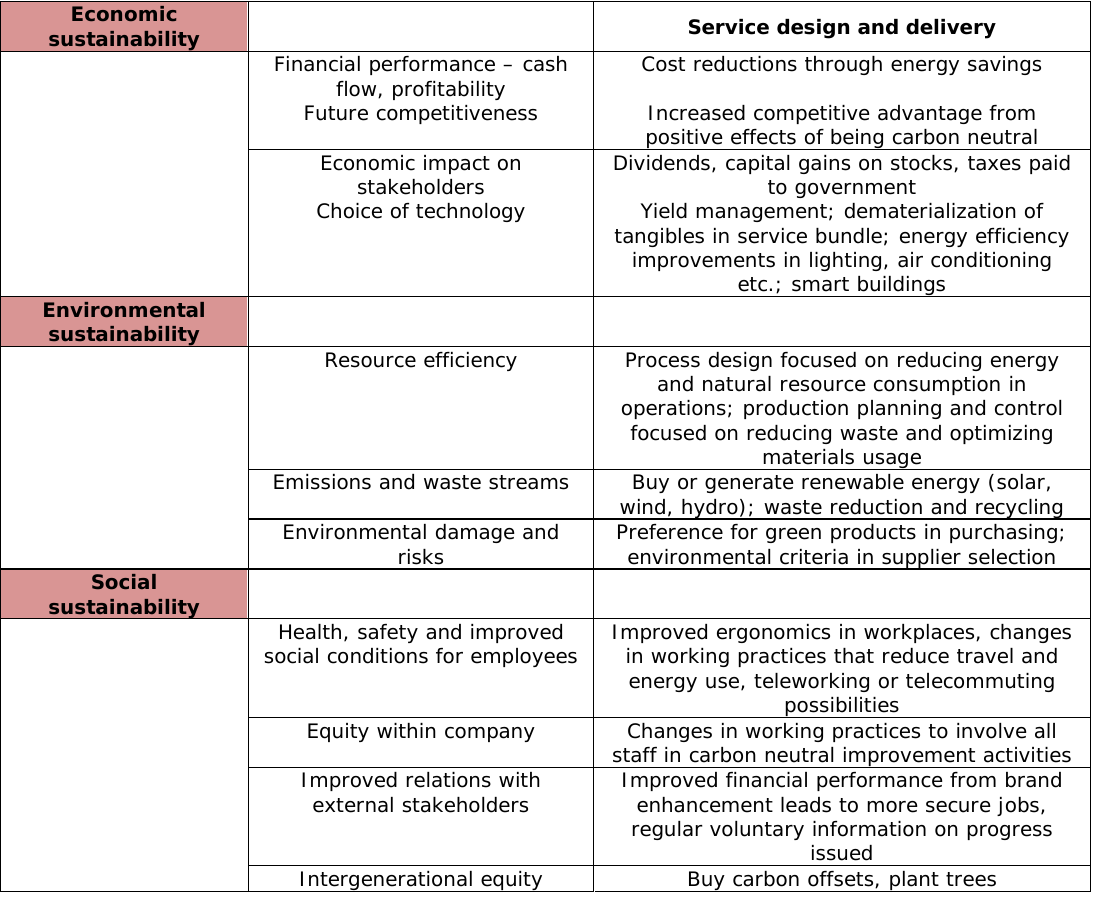
Figure 5: Towards carbon neutrality – subset of typology. Source: